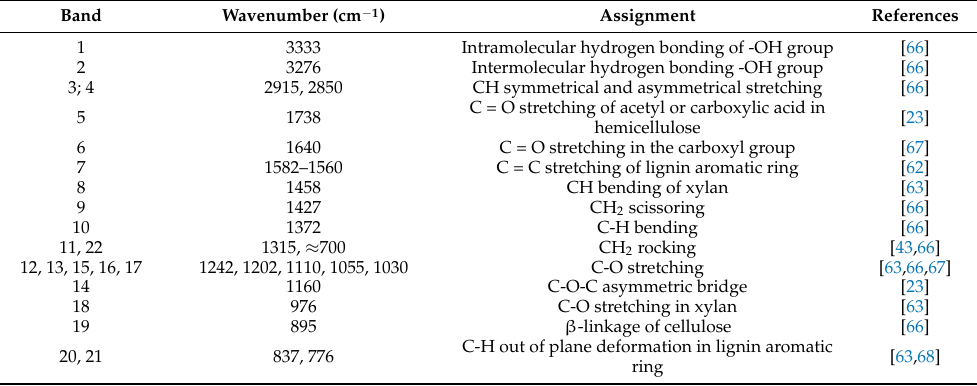
Table 1. Assignments of the infrared absorption